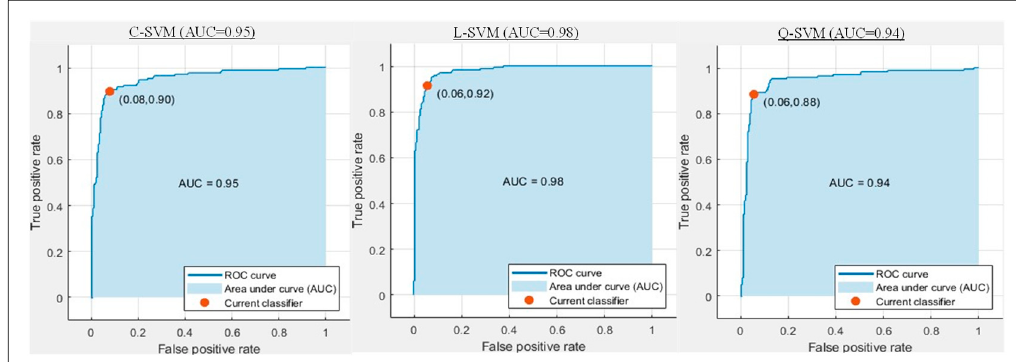
Figure 5. Receiver operating characteristic (ROC) curve behavior and area under the curve (AUC) metric for skin conductance signals per trained model. Red dot in each plot shows classifiers’ optimal performance between true positive rate (TPR) and false positive rate (FPR).